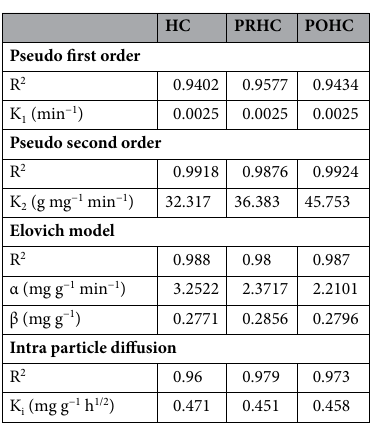
Table 1. Kinetic parameters for Diclofenac adsorption by